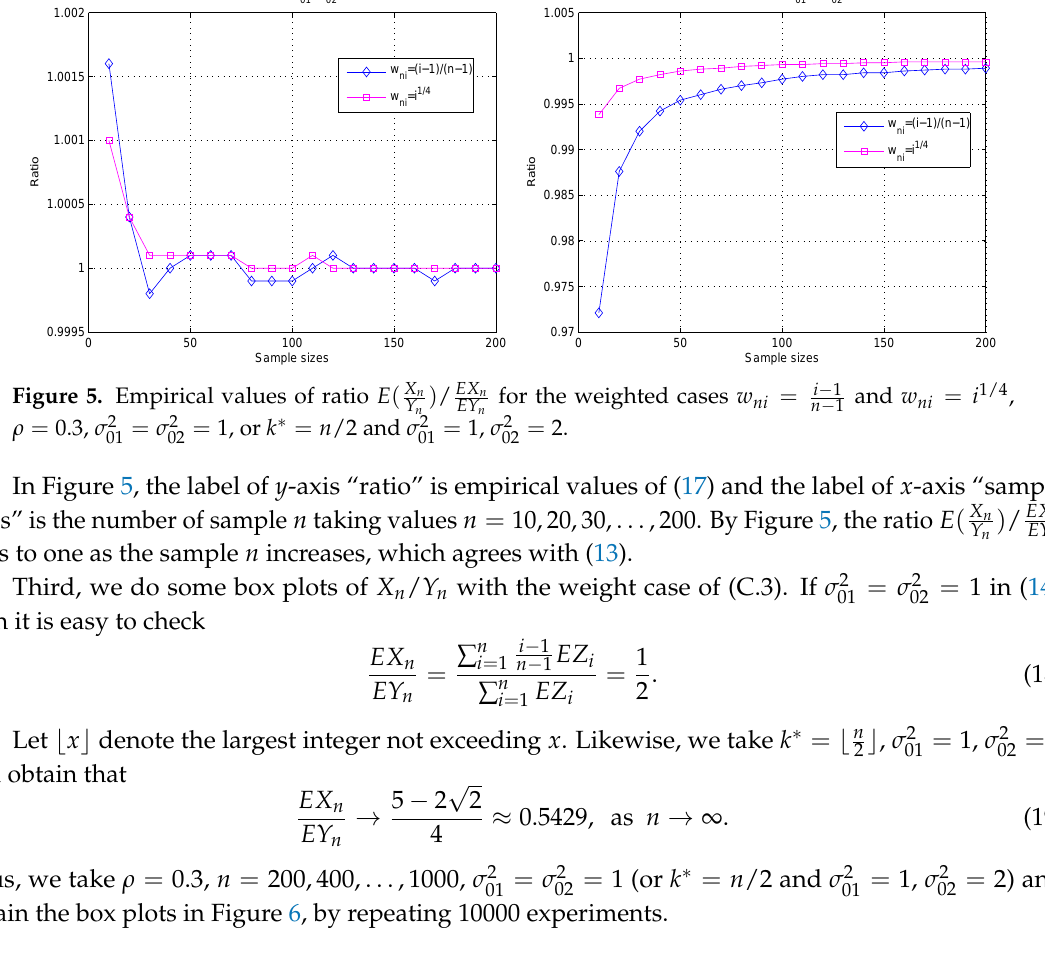
− α for the weighted case w ni = i 1/4 , where ρ = 0.3, ( a + EX n ) − α = 1, σ 2 = 2. 02 01